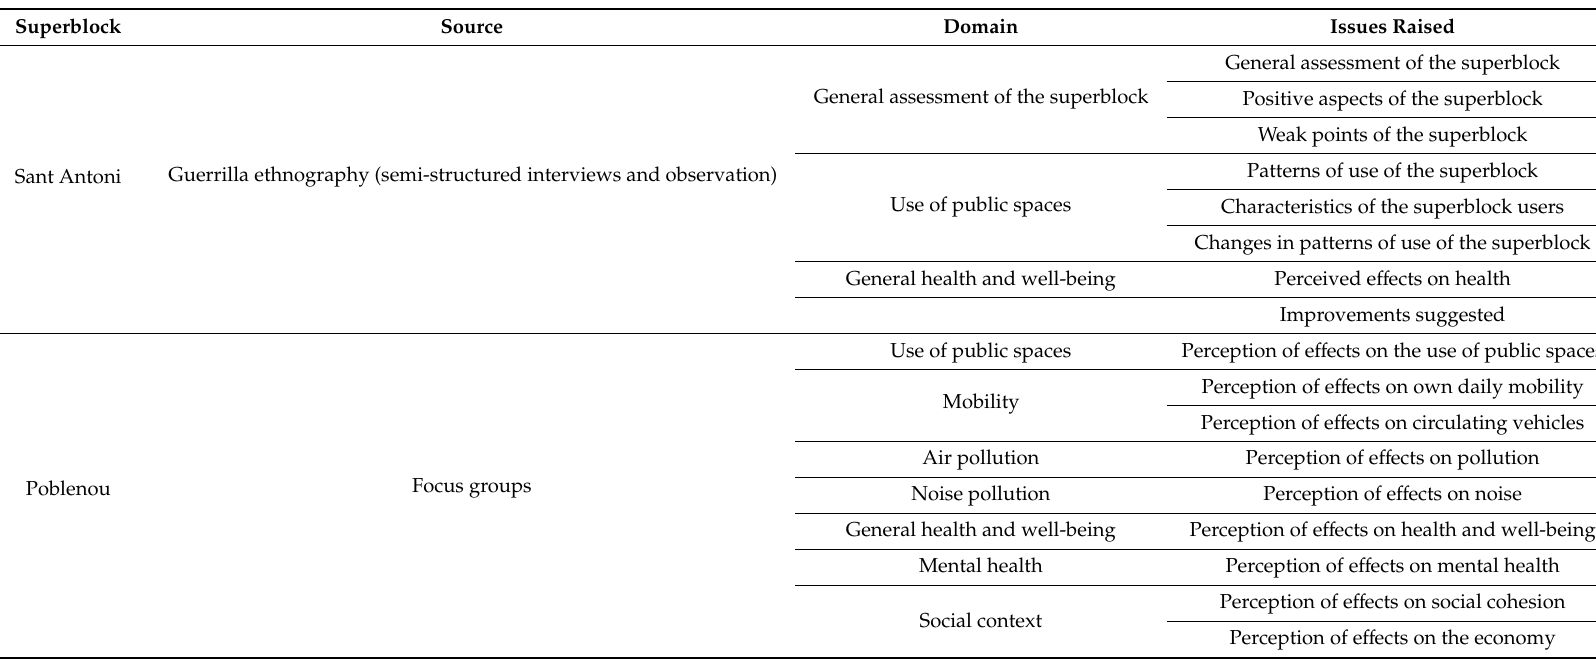
Table 2. Superblock studied, objectives answered, issues raised, and sources used in each Quantitative study of the Salut Als Carrers (SAC)